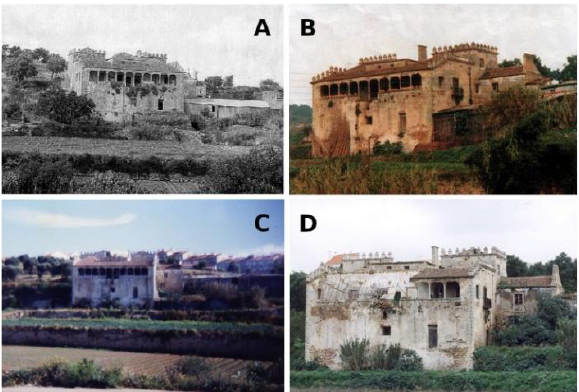
Figure 2. A: 1960, B:1991, C: 1994(8), D: 2001. Source: SIPA and